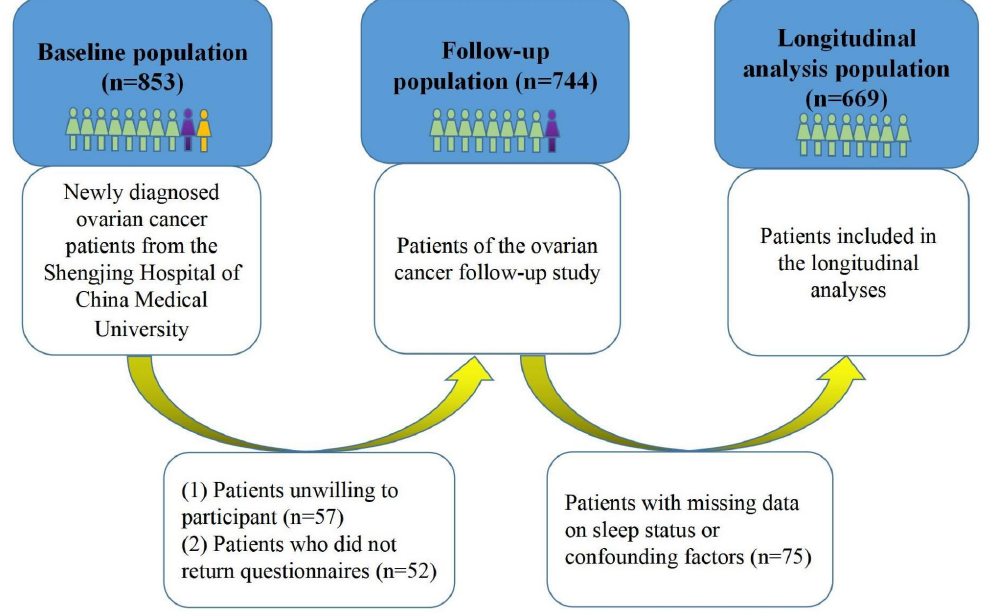
Figure 1. Participant flow chart.